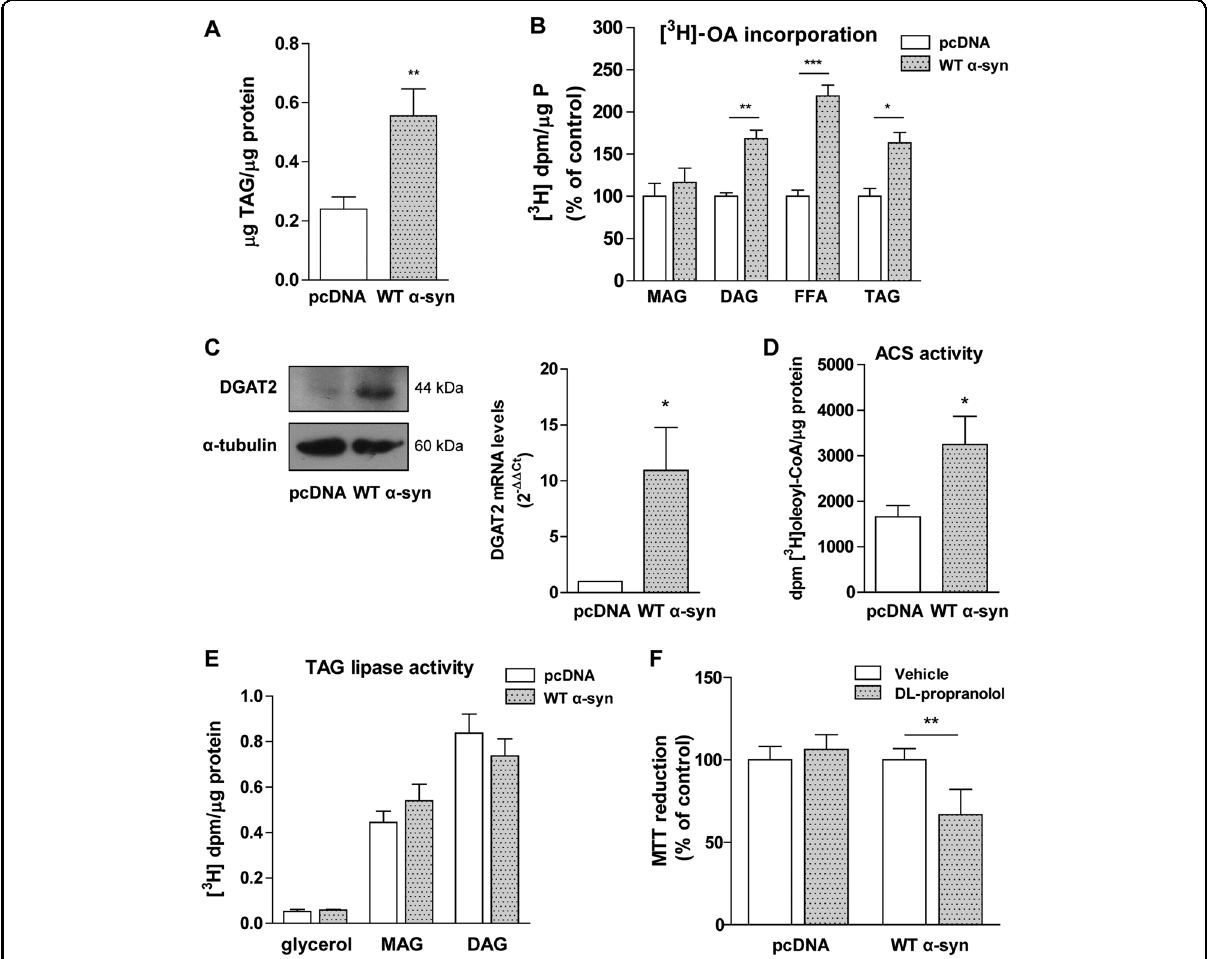
Fig. 2 Impairment in TAG biosynthesis protects against α -syn overexpression. A Cellular TAG content was measured with a detection kit in pcDNA and WT α -syn cells. B [ 3 H]-OA incorporation into MAG, DAG and TAG, and FFA release were measured in our model. C DGAT2 upregulation in cells overexpressing α -syn was determined by Western blot and RT-qPCR. D ACS activity was studied by the measurement of [ 3 H] oleyl -CoA formation in pcDNA and WT α -syn neurons. E TAG lipase activity was determined through the detection of the products of TAG hydrolysis in a radioactivity assay. F The role of TAG biosynthesis during α -syn overexpression was determined in cells treated with the lipin-1 inhibitor DL- propranolol by the MTT reduction assay. A – F All experiments were repeated three times. Bars represent means ± standard deviation (SD, n = 3). * p < 0.05, ** p < 0.01, *** p < 0.001 with respect to the control